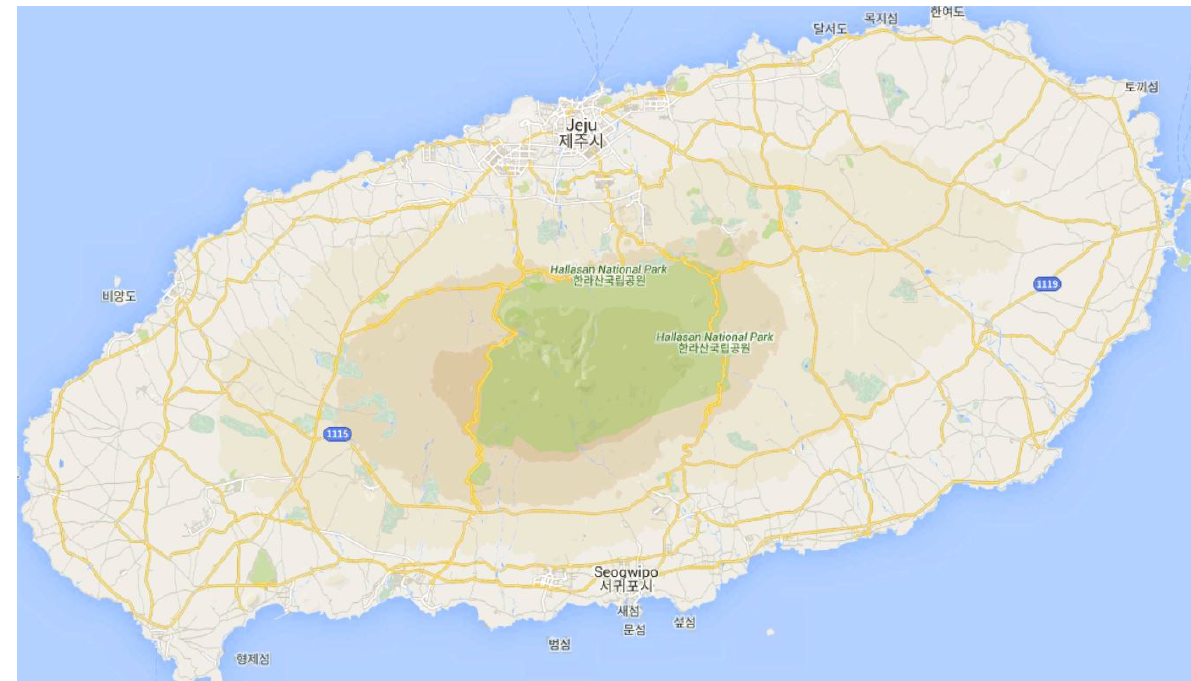
Figure 2. Region partion of Jeju island based on the latitude and longitude into a grid map.